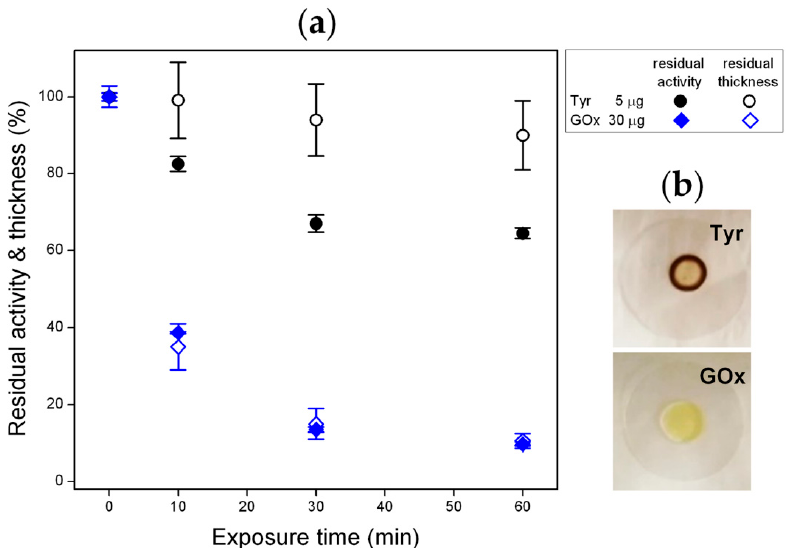
Figure 3. ( a ) Residual activity (closed symbols) and residual thickness (open symbols) of tyrosinase (5 μ g) and glucose oxidase (30 μ g) exposed to DBDs fed with He/1% O 2 mixture for different times (f = 20 kHz, V a = 1.1 kV rms ). Glucose oxidase data are taken from Ref. [35]. ( b ) Representative pictures of Tyr and GOx deposits onto glass slides after drying (large amounts of enzyme were utilized to make the deposit morphology more visible in the pictures).